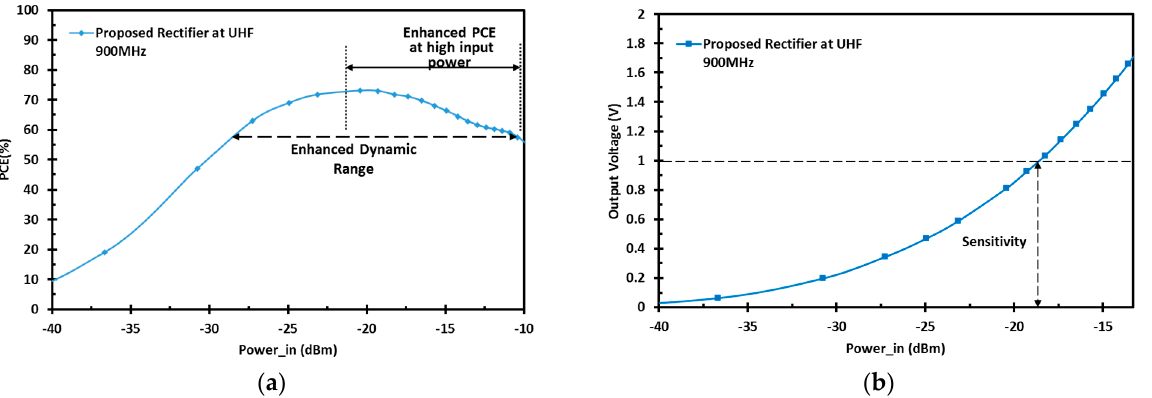
Figure 13. Post-layout simulation results of ( a ) the PCE vs. input RF power; ( b ) output DC voltage vs. input RF power.